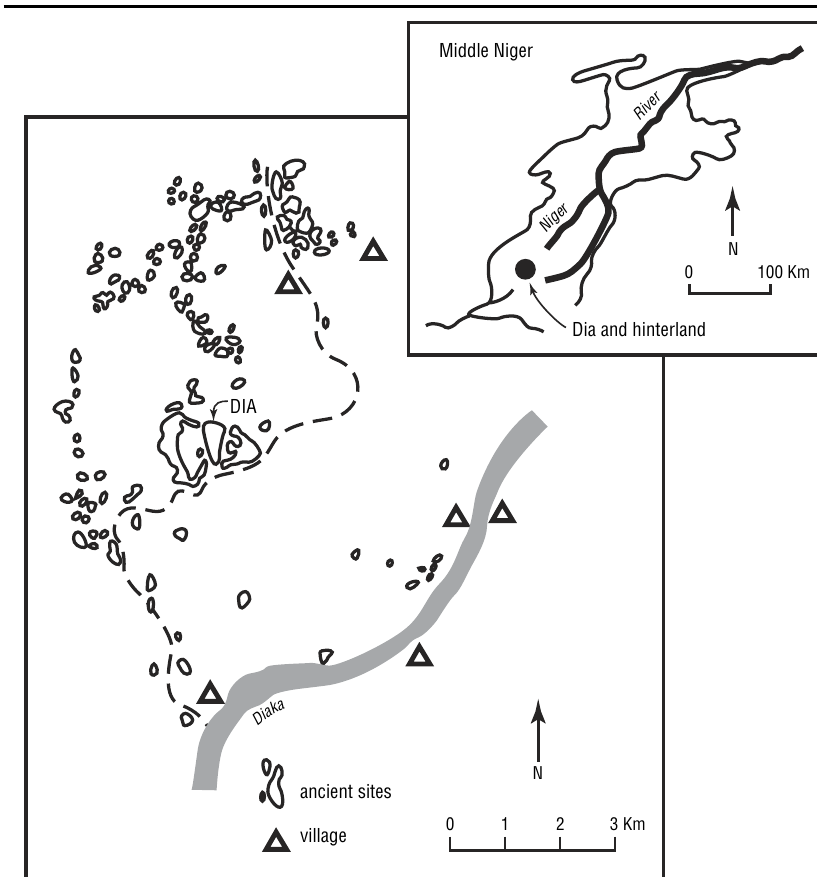
Figure 17 – Clustered specialist settlements within 4 km of Jenne-Jeno Figure 18 – Dia-Shoma and its Clustered